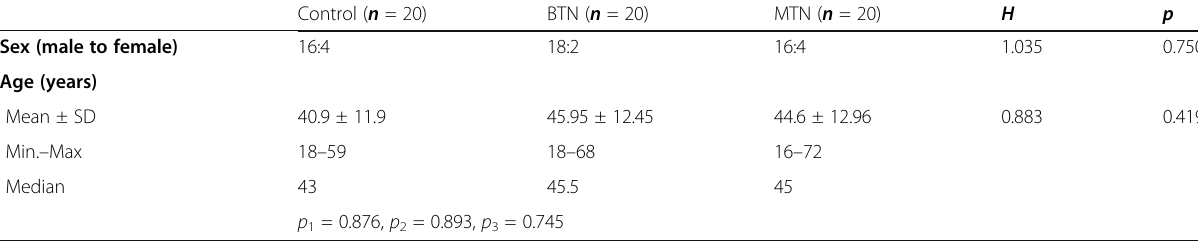
Table 1 Comparison of sex and age between the studied groups Control ( n = 20) BTN ( n = 20) Sex (male to female)